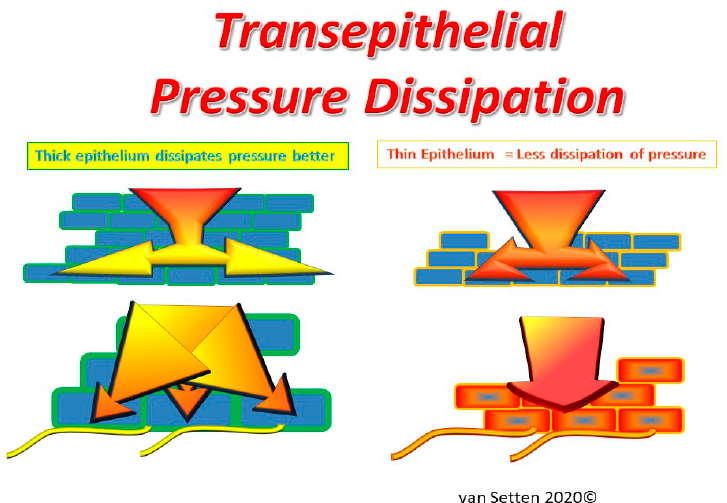
Figure 2. Illustration of the effects of epithelial thinning on transepithelial pressure dissipation, where under physiological conditions, the multilayered normal epithelium dissipates pressure better than a compressed and thinned epithelium with less capacity for dissipation of pressure. The mechano- transduction of any pressure is much more directly directed to the basal cell layer in a thinned epithelium and hence, more likely to cause secondary effects, such as inflammation and pain.